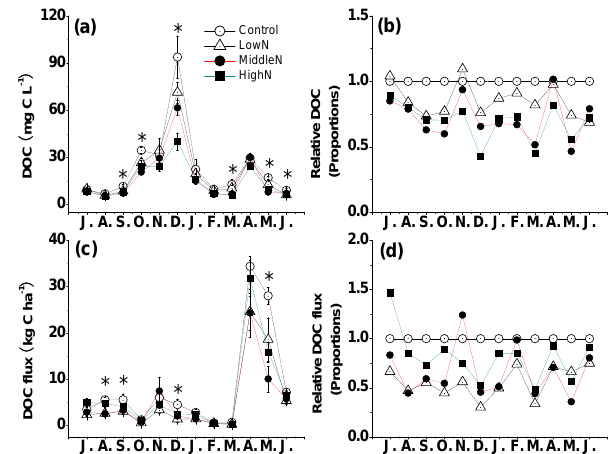
Fig. 1. Responses of DOC concentration (a) and its relative con- centration (b) , and DOC efflux (c) and its relative efflux (d) to long-term N addition below the primary rooting zone in the lowland tropical forests of Southern China. Soil leachate data were available from July 2009 to June 2010. Notes: Asterisk ( ∗ ) indicates that there are significant differences at P < 0 . 05 level between N treatments and the Controls using planned contrast